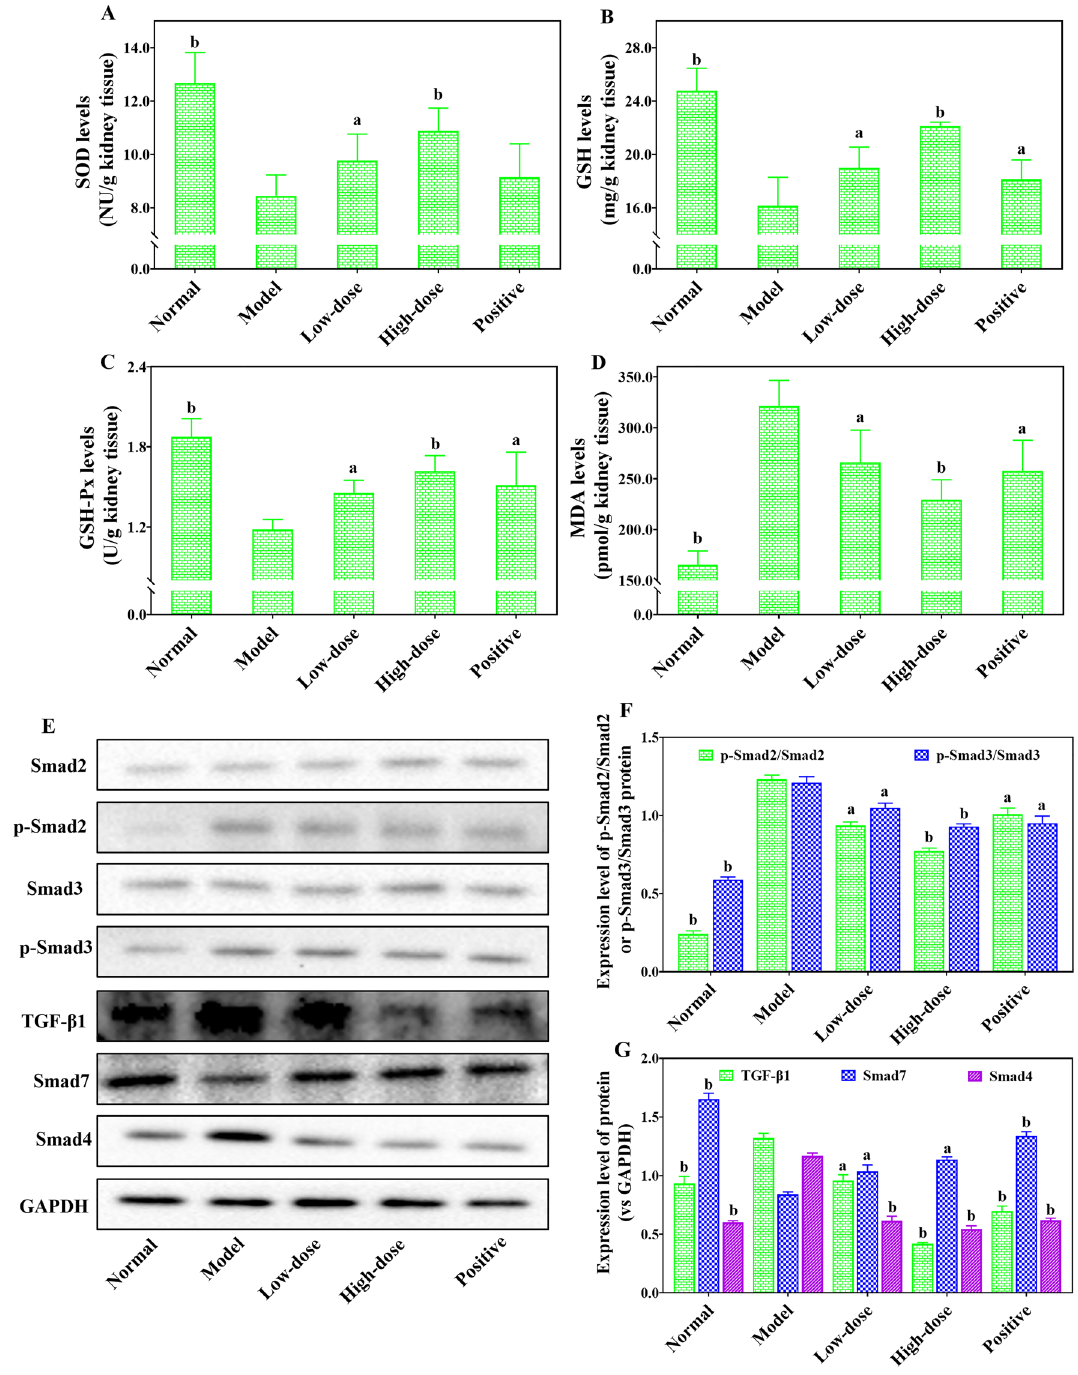
Figure 7. The effects of COS on the oxidative stress injury indicators and expression level of TGF-β/Smads signaling pathway protein from kidney tissues in UUO-induced renal fibrosis mice. SOD levels ( A ). GSH levels ( B ). GSH-Px levels ( C ). MDA levels ( D ). Representative Western blot analysis bands of TGF-β/Smads signaling pathway protein ( E ). Quantitative statistical chart from western blot analysis of p-Smad2/Smad2 and p-Smad3/ Smad3 proteins ( F ). Quantitative statistical chart from western blot analysis of TGF-β1, Smad7 and Smad4 proteins ( G ). The original bands of Western blot from ( E ) were shown in the Supplementary Fig. S1. All values are represented as mean ± SD (n = 10 in each group). Superscript letters a and b designate significant differences. a P < 0.05 compared with the model group. b P < 0.01 compared with the model